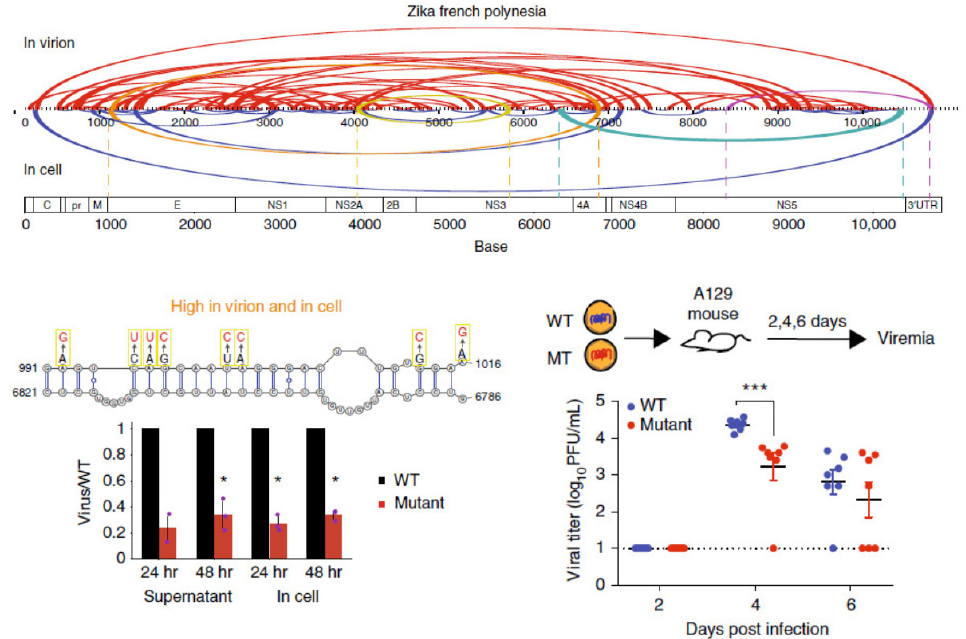
Figure 1. ( Top ), pairwise RNA–RNA interactions along the Zika virus genome when the genome is inside virion particles and inside cells. ( Bottom left ), RNA cofold models of pairwise RNA interactions and mutations along the interaction. Mutations decrease the ability of the virus to grow inside cells. * p < 0.05 (Student T-test, two-tailed). ( Bottom right ), mutant viruses show lower levels of viremia in mice, indicating that they are attenuated. *** p < 0.001 (Mann-Whitney U test). Image retrieved from an open access article [34] distributed under the terms of the Creative Commons CC BY